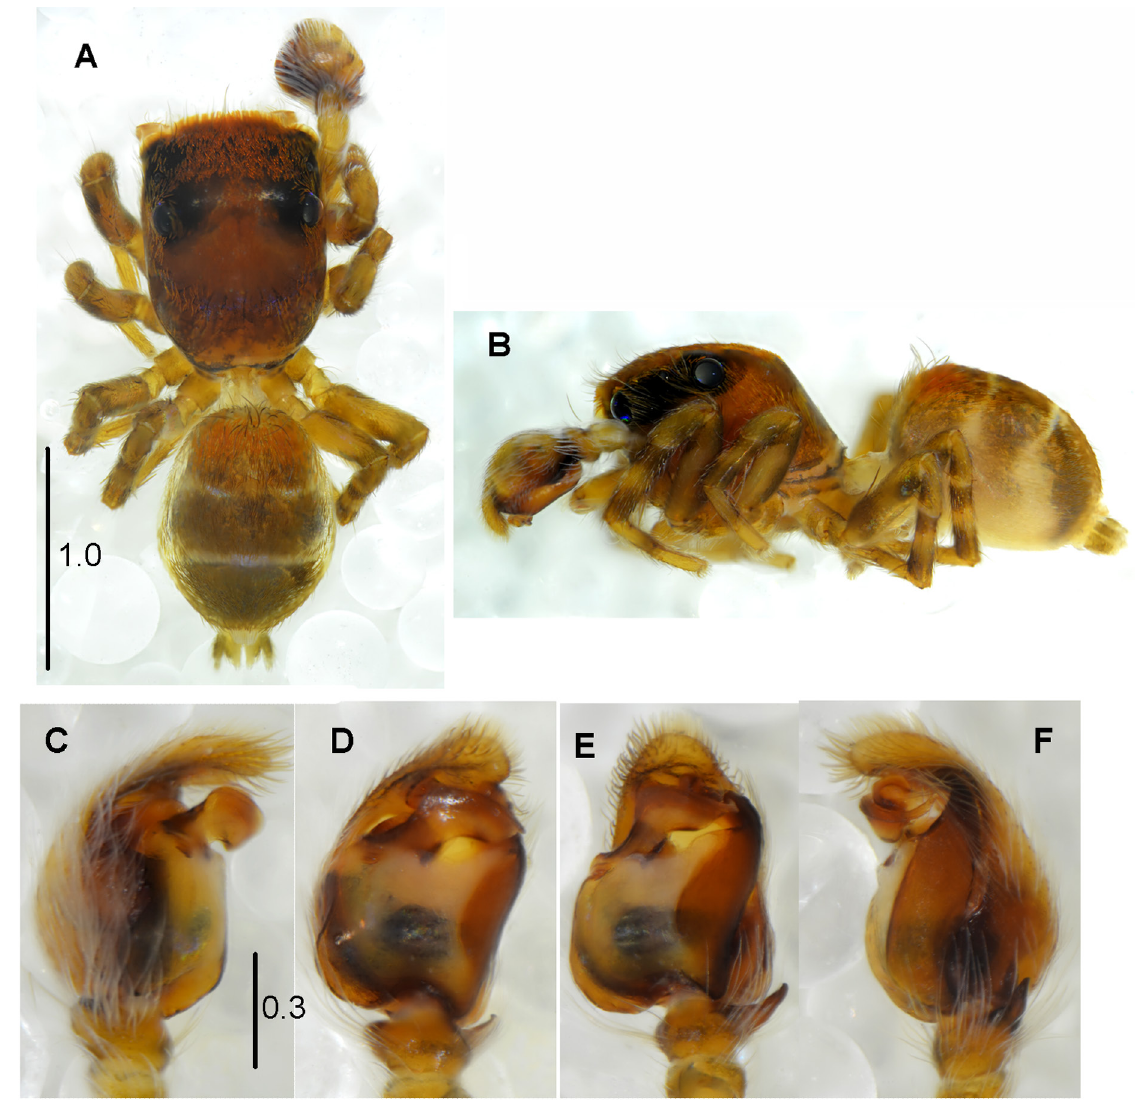
Fig. 56. Pulcherula magna gen. et sp. nov., holotype, ♂ (MNHN). A . Habitus, dorsal view. B . Habitus, lateral view. C . Palpal organ, prolateral view. D–E . Palpal organ, ventral view. F . Palpal organ, retrolateral